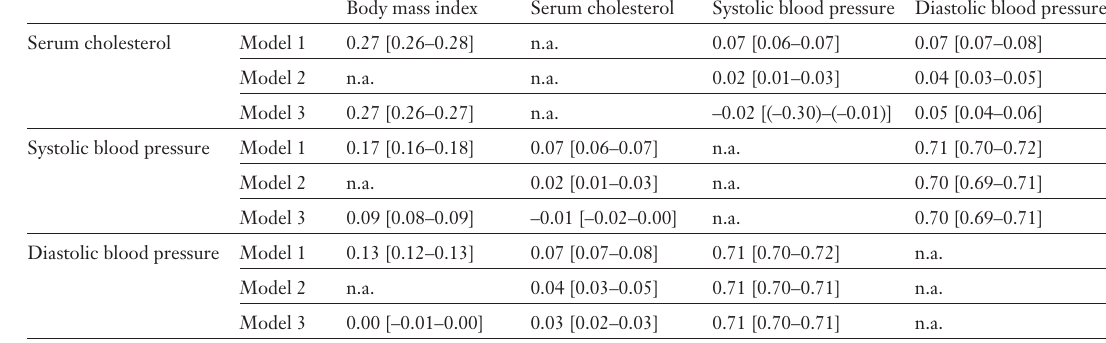
independent variables whereas the respective fourth of these variables serves as dependent variable in the regression models.